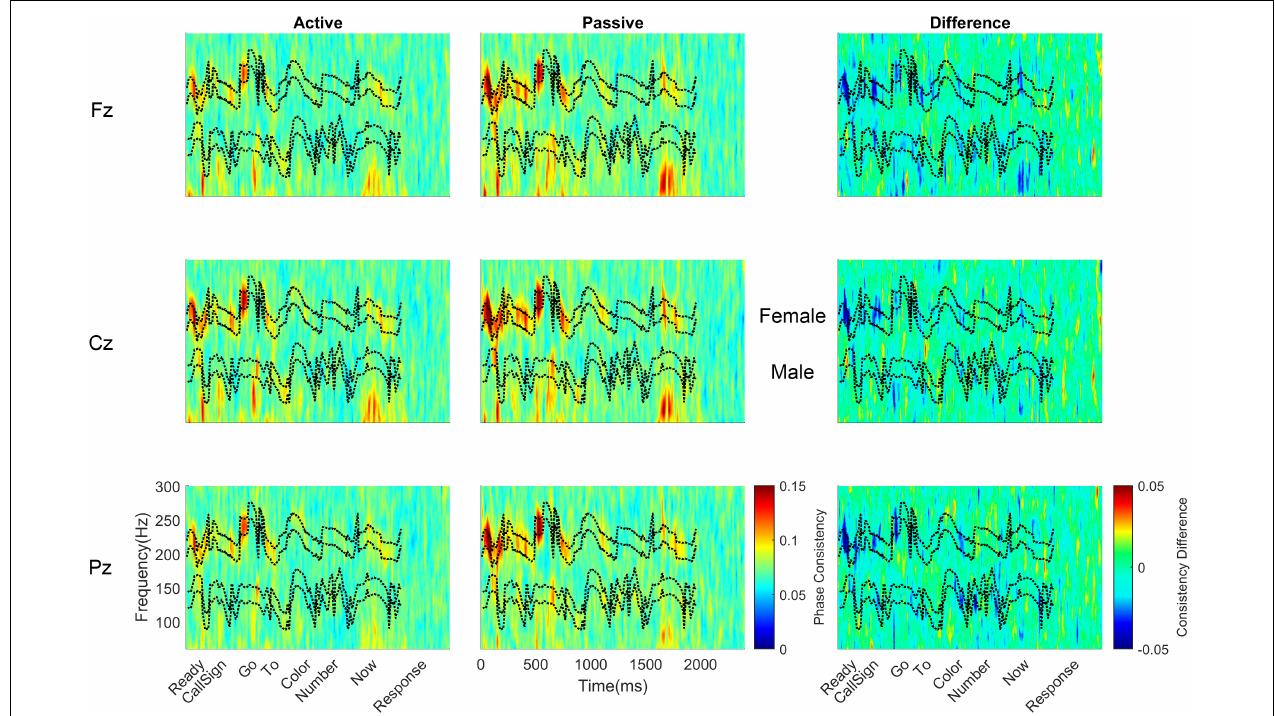
FIGURE 5 | Monolingual subcortical phase consistency. Monolingual phase consistency is plotted at Fz (top) , Cz (middle) , and Pz (bottom) for active (left) and passive (center) listening conditions. For these six plots, color represents greater phase consistency, with warmer colors indicating greater consistency and cooler colors representing little to no consistency. The rightmost plots show the difference in phase consistency between active and passive listening conditions, with warmer colors indicating greater consistency during active listening and cooler colors indicating more consistency during passive listening. The top two black dashed lines in each plot indicate the female pitch contour + 10 Hz and the bottom two dashed lines indicate the male pitch contour + 10 Hz (labeled between the passive and difference plots for Cz). Note that the regions that have multiple words (e.g., number) have no phase consistency while phase consistency is evident over the words that are identical across trials (i.e., ‘ready,’ ‘go,’ ‘to,’ and ‘now’). Monolinguals’ subcortical phase consistency decreased during active listening, in contrast to the effects of active listening on cortical phase